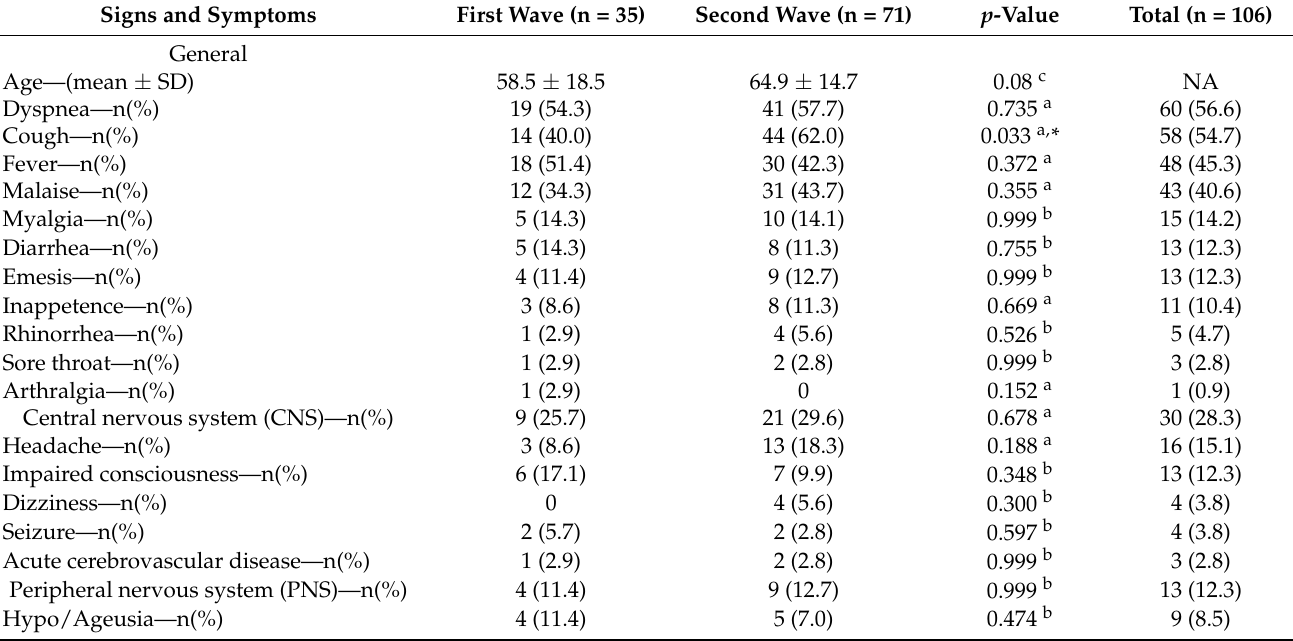
Table 7. Description of signs and symptoms in patients with